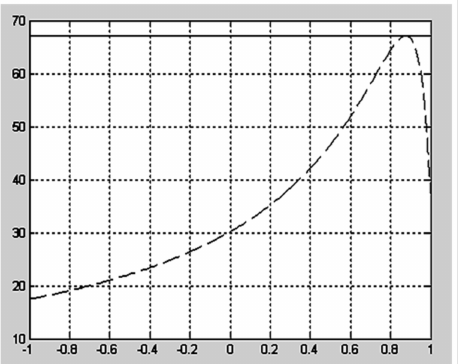
Figure 9. Operating device profiles dependences taking into account conditions 12 and 13. Dashed line—profile of equal strength; solid line—optimal profile under Restriction VI